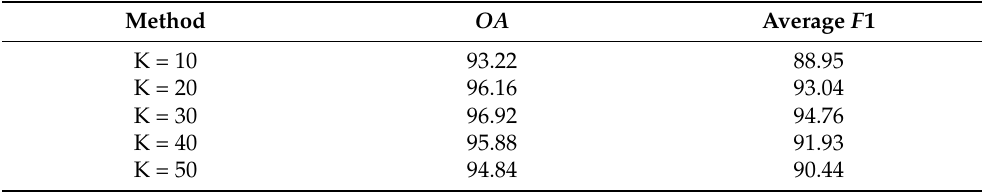
Table 5. Comparison of the different K values in calculating the normal vector of the point cloud.